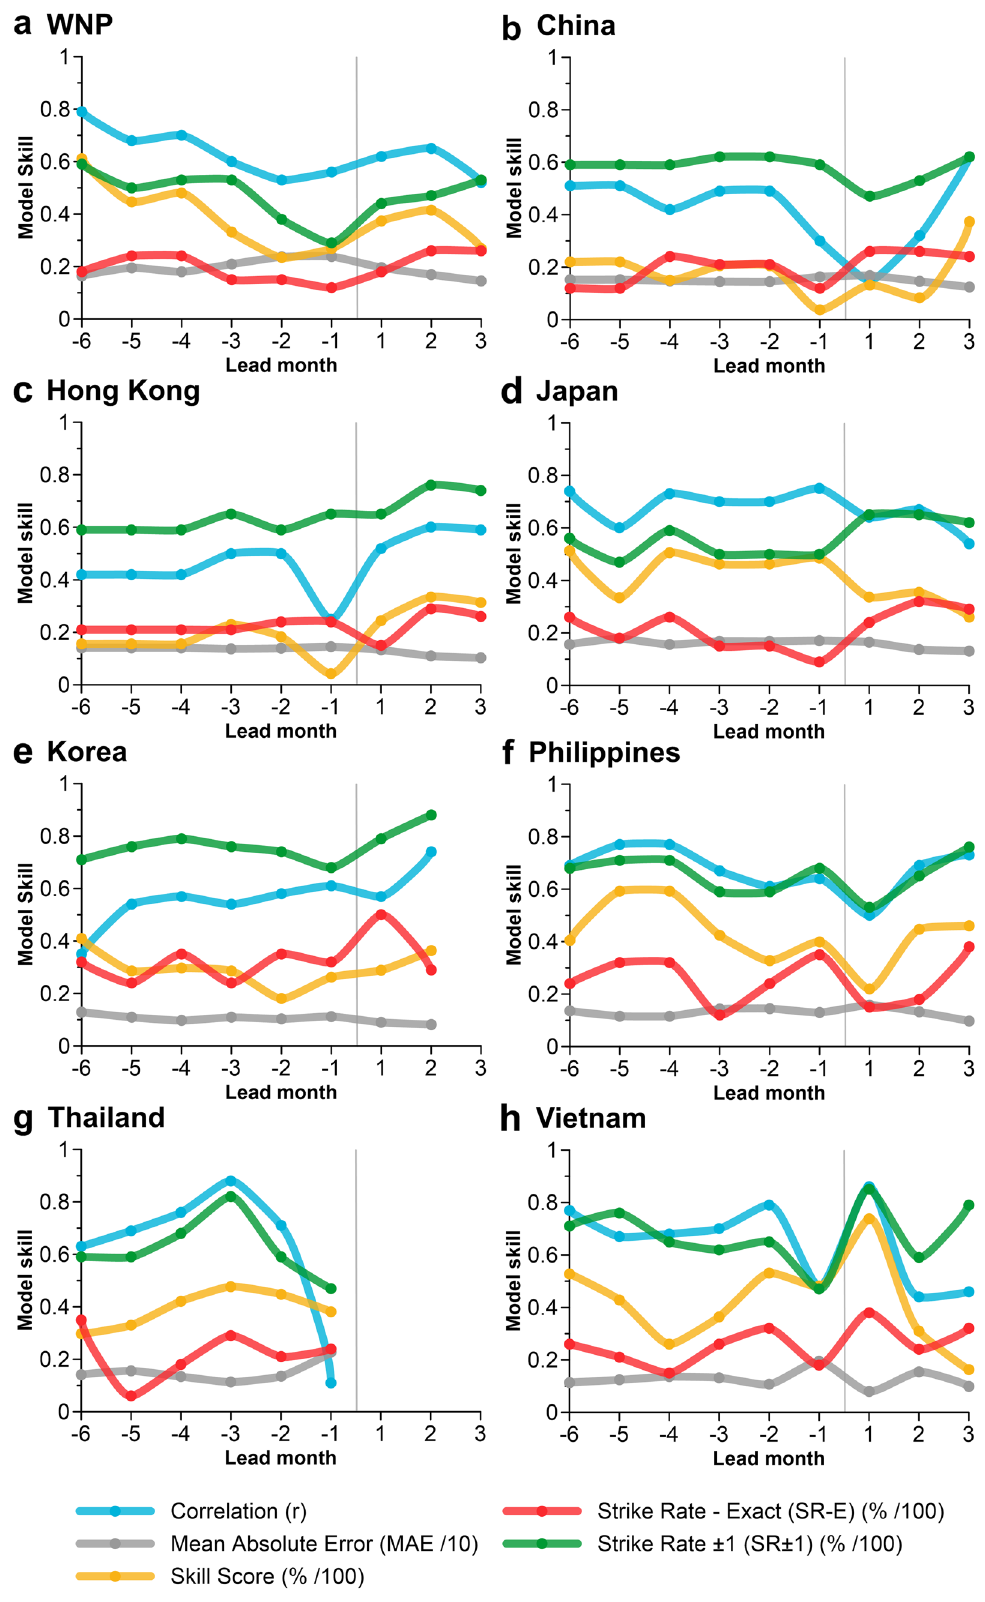
Figure 5. Evaluation of Leave-One-Out Cross Validation (LOOCV) model performance for all typhoons (where maximum sustained winds ≥ 64 kt; TY + STY events) for eight locations between 1987 and 2020. The vertical line separates the pre-season (lead − 1 to lead − 6) and in-season (lead + 1 to lead + 3) outlooks. Lead months with missing model performance statistics (e.g. Lead + 3 for e ) indicates negligible/no model